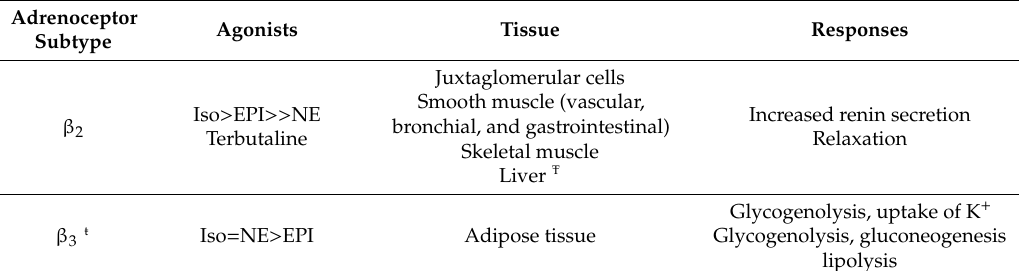
Table 1. Cont. Table 1. Characteristics of subtypes of adrenergic receptors.